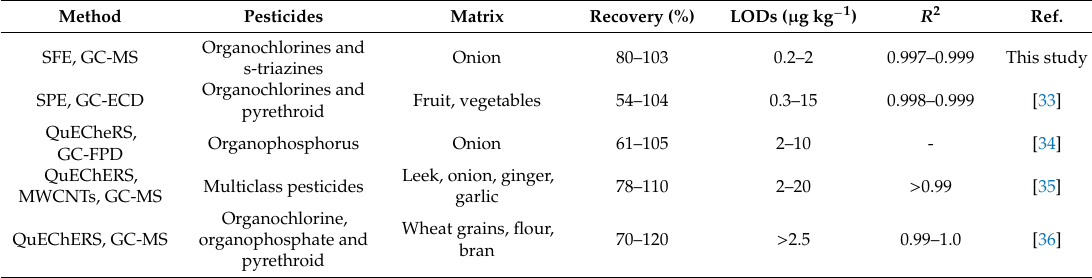
Table 4. Comparison of the new method with published methods found in the